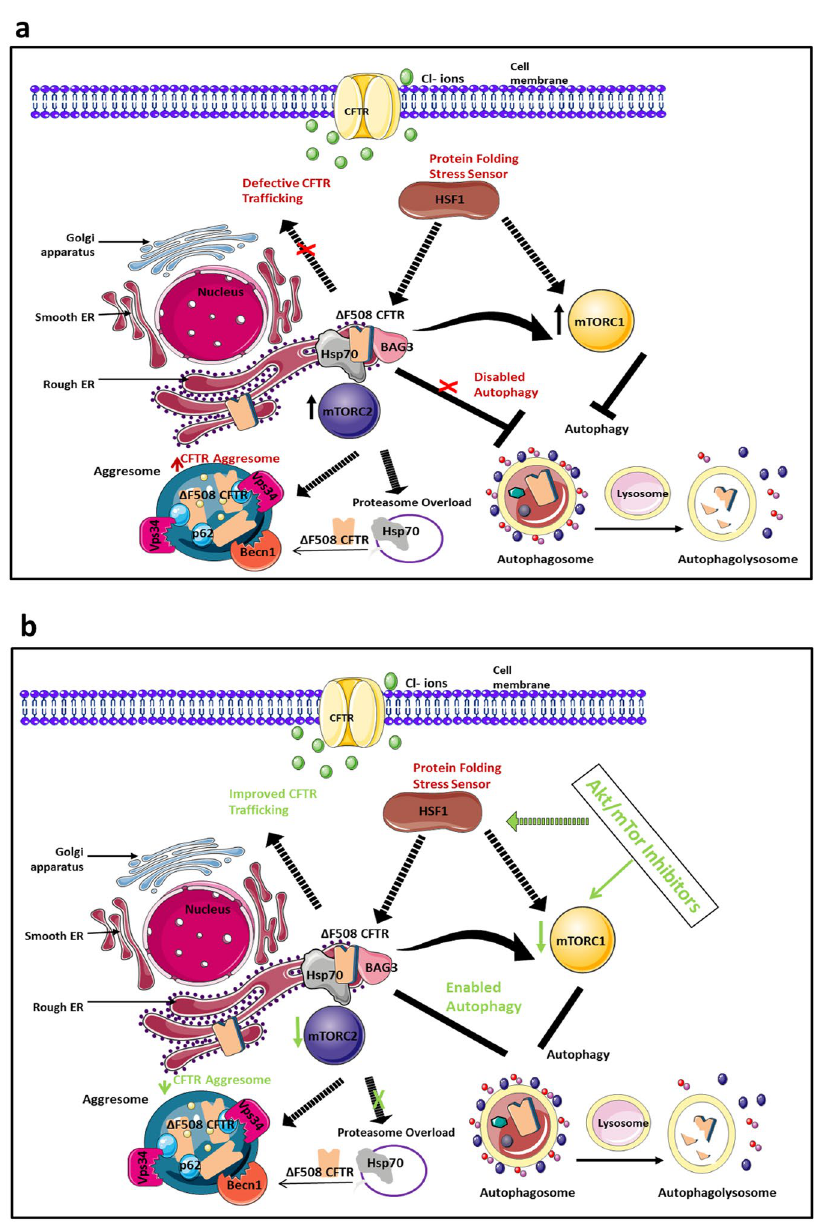
Figure 6. Regulation of Δ F508 CFTR stability by inhibitors to the PI3K/Akt/mTOR pathway. ( a ) The Δ F508 variant of CFTR is characterized by ER accumulation, misfolding and an inability to traffic correctly to the plasma membrane where it functions as a chloride channel. It is believed that Δ F508 CFTR is retained in the ER in a Hsp70/90-containing chaperone trap influenced by the stress response sensor Heat Shock Factor (HSF1). Degradation of CFTR by the ERAD machinery is favoured but when CFTR that cannot be degraded by the proteasome machinery, (proteasome overload), CFTR can be stocked in the cytoplasm in the form of aggresomes. Our results indicate that mTORC1/2 signalling is upregulated in Δ F508 CFBE cells which have a defective autophagy pathway. Defective autophagy has been connected to reduced aggresome clearance. We observed CFTR localisation within aggresomes in Δ F508 CFBE41o- cells under conditions of proteasome inhibition. ( b) In the presence of inhibitors to the PI3K/AKT/mTOR (eg MK-2206) we observed a decrease in mTORC1/2 activation and a corresponding increase in autophagic activity. We detected an increase in CFTR stability/trafficking upon therapeutic intervention of this pathway. We also revealed that HSF1 and BAG3 expression (which is stimulated by HSF1) are potentially regulated by PI3K/AKT/mTOR inhibitors. These data suggest that selective PI3K/Akt/mTOR inhibitors, such as MK-2206, may improve CFTR stability by both restoring autophagy through inhibition of mTOR and through the HSF1/BAG3 axis which, in turn, can regulate autophagy and Δ F508 CFTR aggregates. This figure was produced, in part, by using Servier Medical Art, (www.